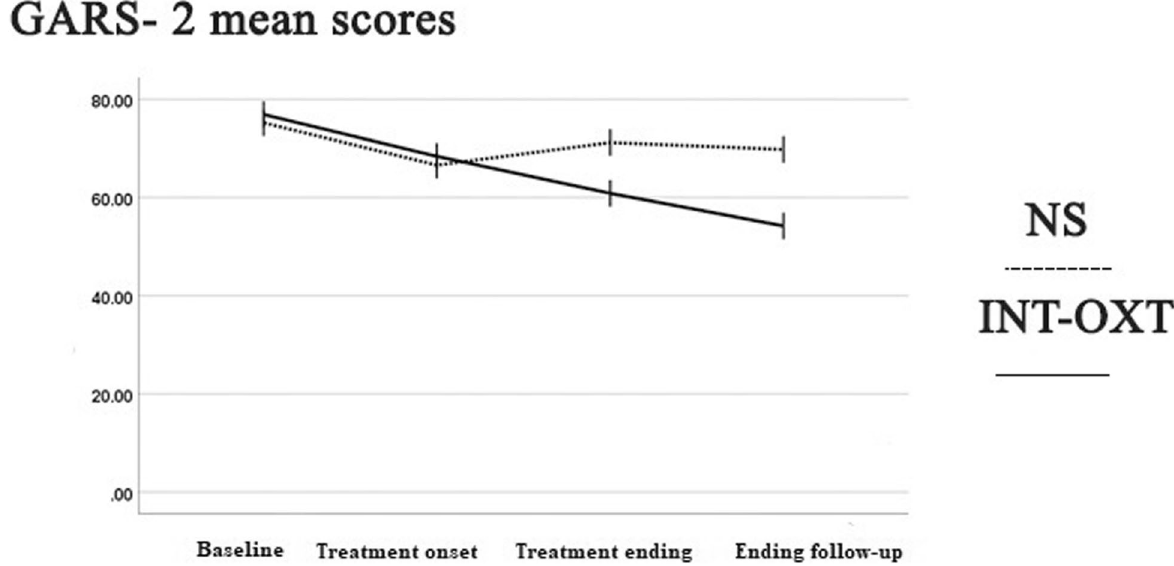
Fig. 2 Changes in the Gilliam Autism Rating Scale-2 (GARS-2) mean scores in two groups during the study period. INT-OXT, intranasal oxytocin; NS, normal